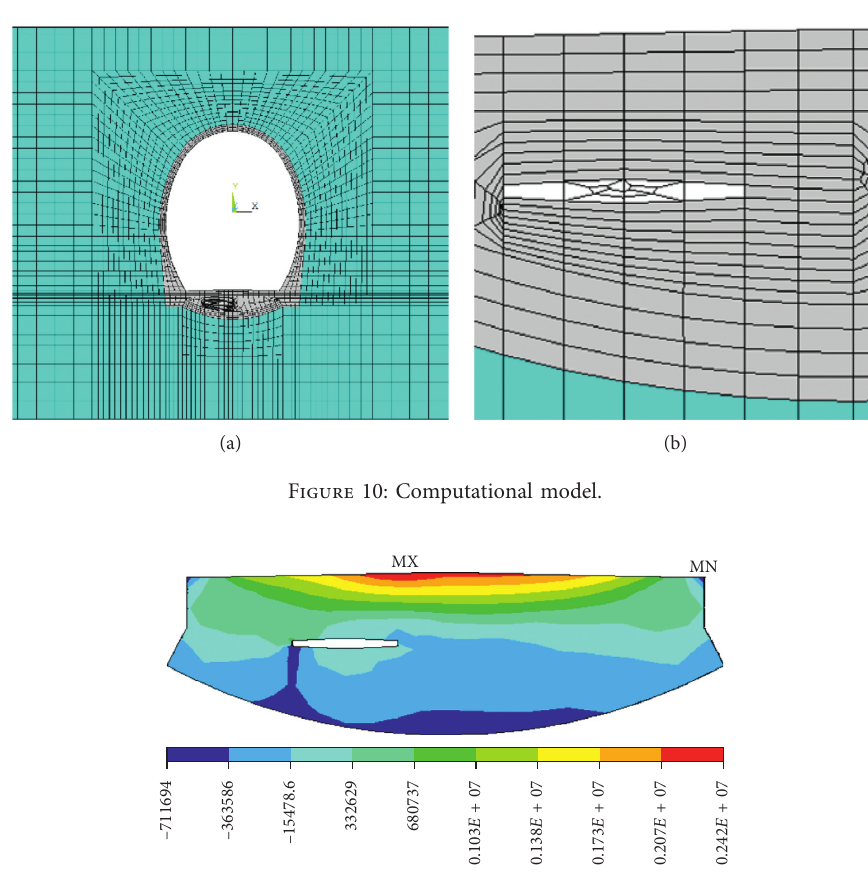
Figure 11: First principal stress of tunnel substructure (Pa) before the treatment.